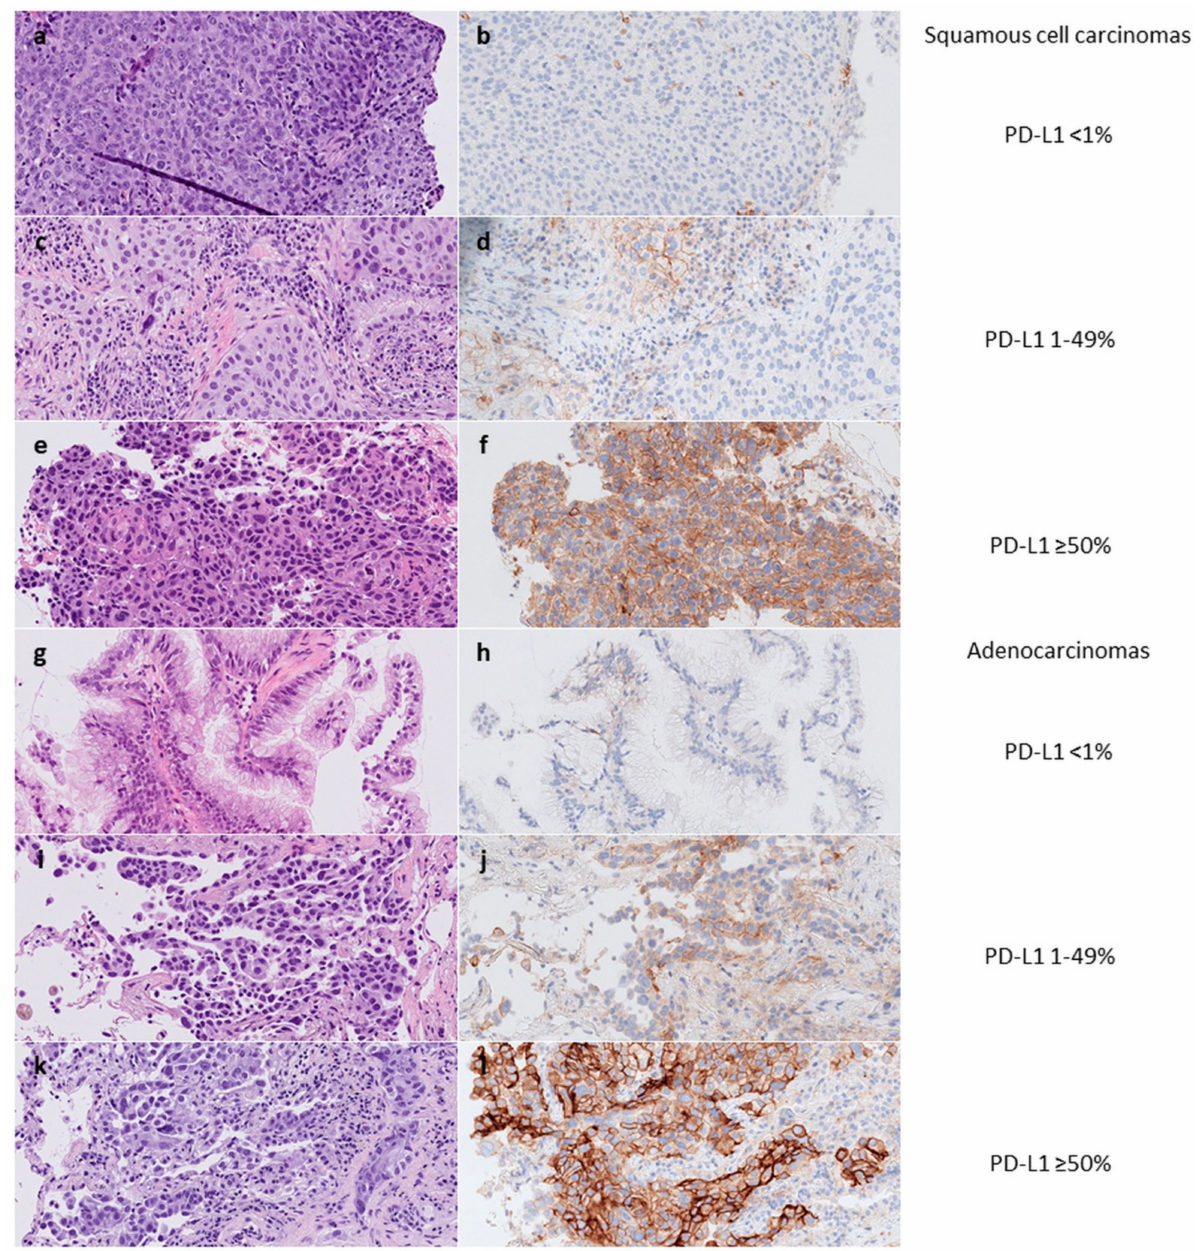
Figure 1. PD-L1 expression in <1% ( b , h ), 1-49% ( d , j ), and ≥ 50% ( f , l ) of tumor cells in biopsies with squamous cell carcinomas ( a – f ) and adenocarcinomas ( g – l ). Staining with hematoxylin-eosin and PD-L1 clone 22C3. Original magnification x40